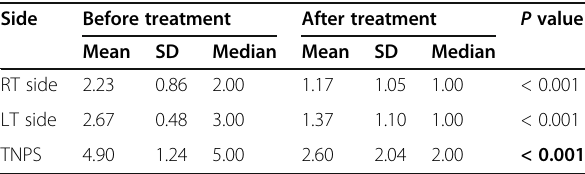
Table 6 Total nasal polyps score (TNPS) before and after treatment in the oral steroid group Side Before treatment After treatment P value RT side 2.23